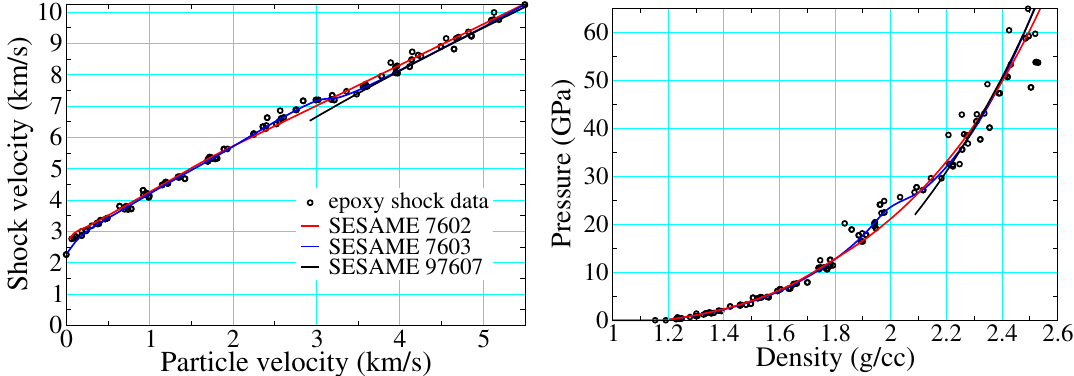
Figure 15. Hugoniot data for epoxy taken from Refs. [31,38,100,101], as compared with those calculated using three different numbered equations of